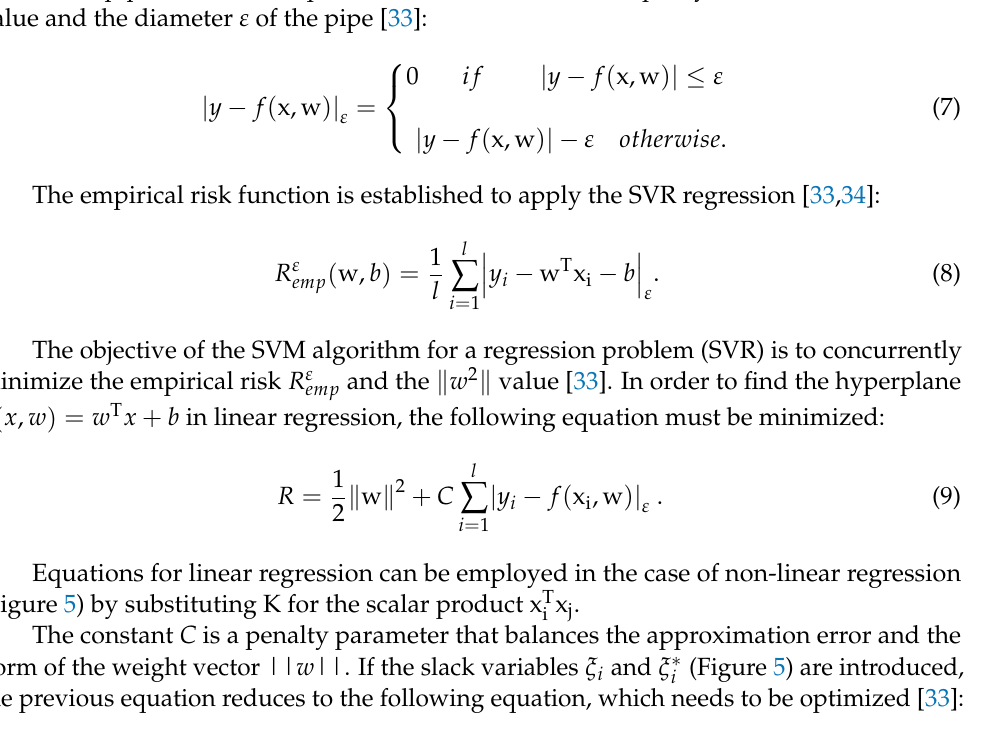
Figure 5. The support vector machine method with the so ‐ called Vapnik’s error function [2]. The error function defined in this way can be defined as an 𝜀 cylinder or tube. If the prediction values are inside the tube, the error is zero. For all other prediction values outside the pipe, the error is equal to the amount of the discrepancy between the forecasted value and the diameter 𝜀 of the pipe [33]: